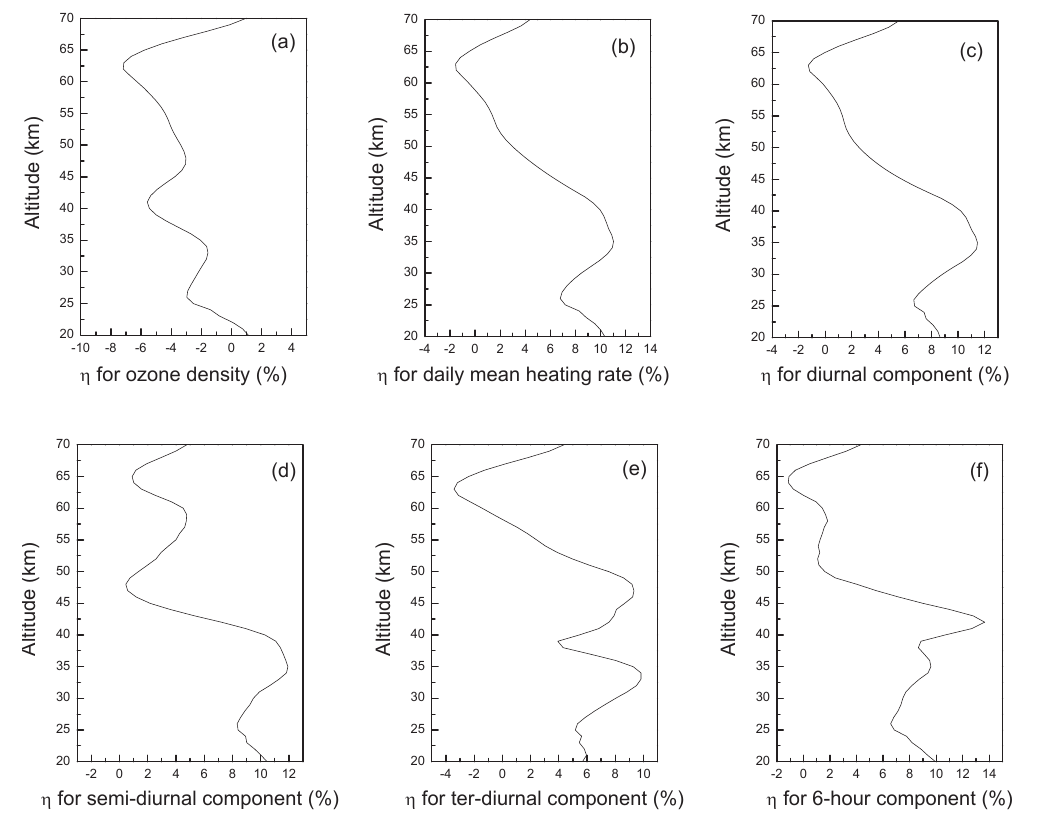
Fig. 5. The degrees of the seasonal asymmetry (%) between DJ and JJ of the global averages of (a) ozone density; (b) daily mean heating rate; (c) coefficient of the diurnal component; (d) coefficient of the semidiurnal component; (e) coefficient of the 8-h component; (f) coefficient of the 6-h